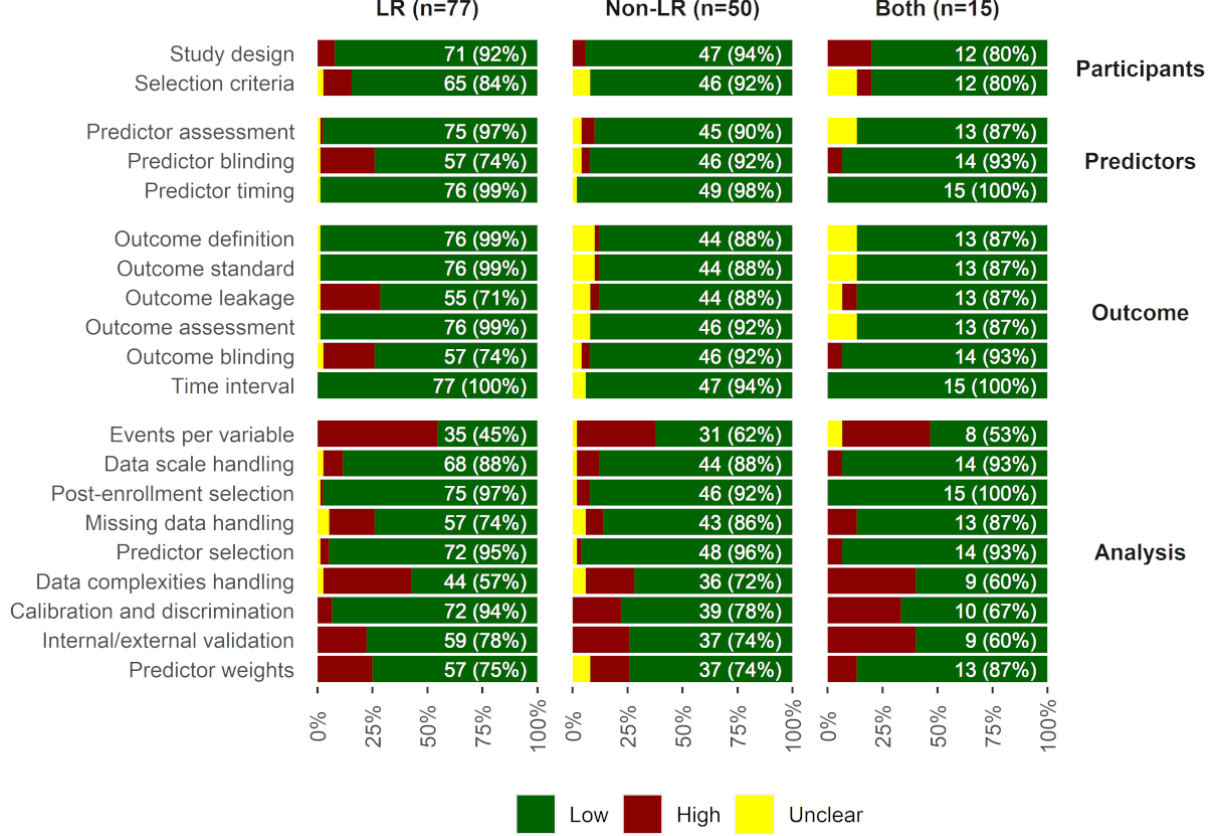
Figure 2. Signaling questions with respect to ROB domains across studies. Bars from low/high/unclear ROB are stacked to be 100%. Domains are described on the right-hand side. The number on the bar is the number of low ROB studies (total LR/non-LR/both at top) based on a single